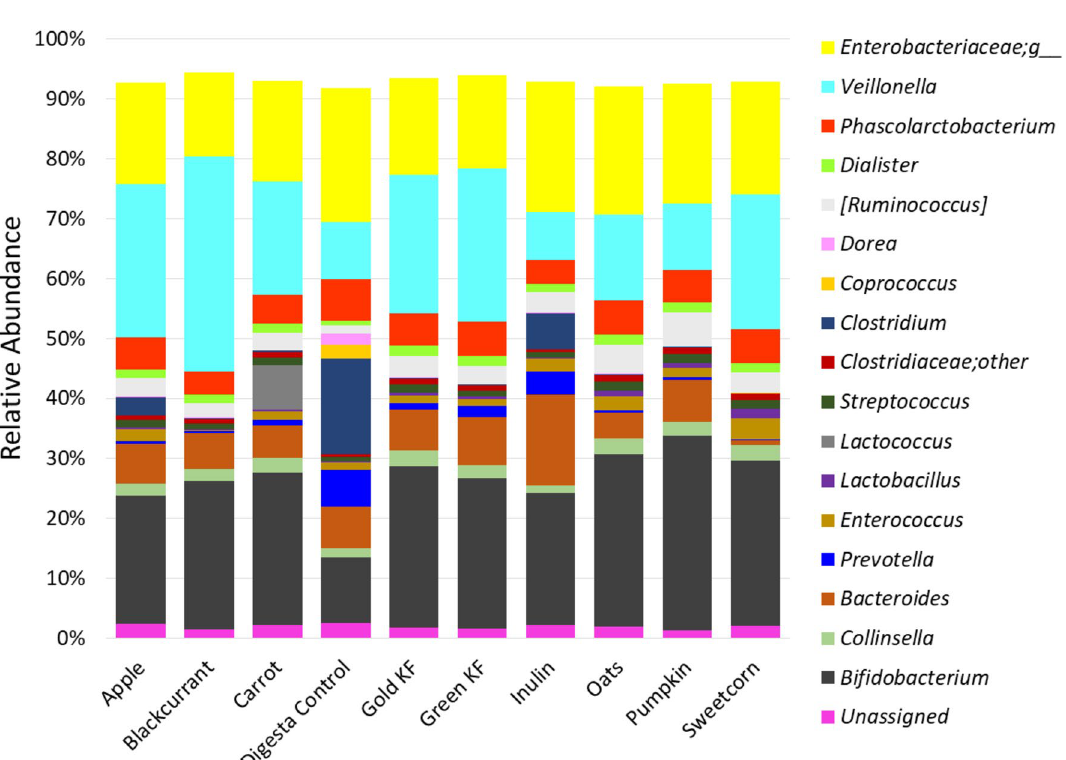
Figure 5. Significant changes in relative abundances in the infant faecal bacteria at the end of 10 h of fermentation. Genera/taxa with ≥ 1% relative abundance in at least one sample depicted. The significance values adjusted to the false discovery rate were P < 0.005, the likelihood ratio test was adjusted for 32